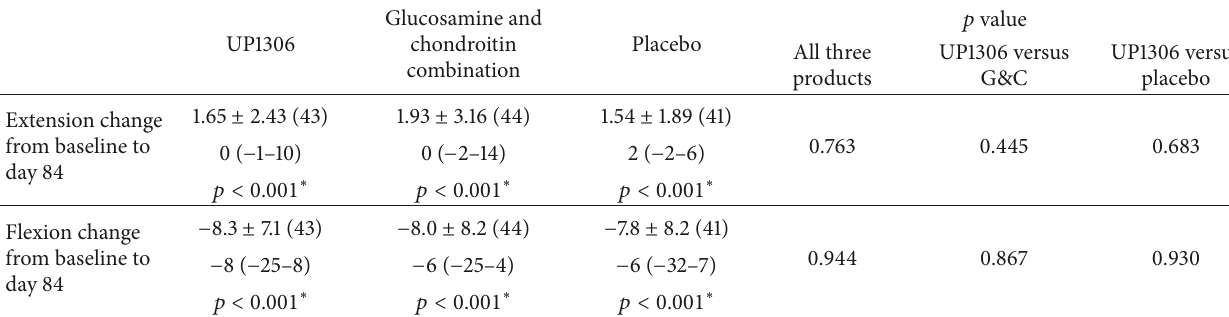
Table 3: Range of motion.